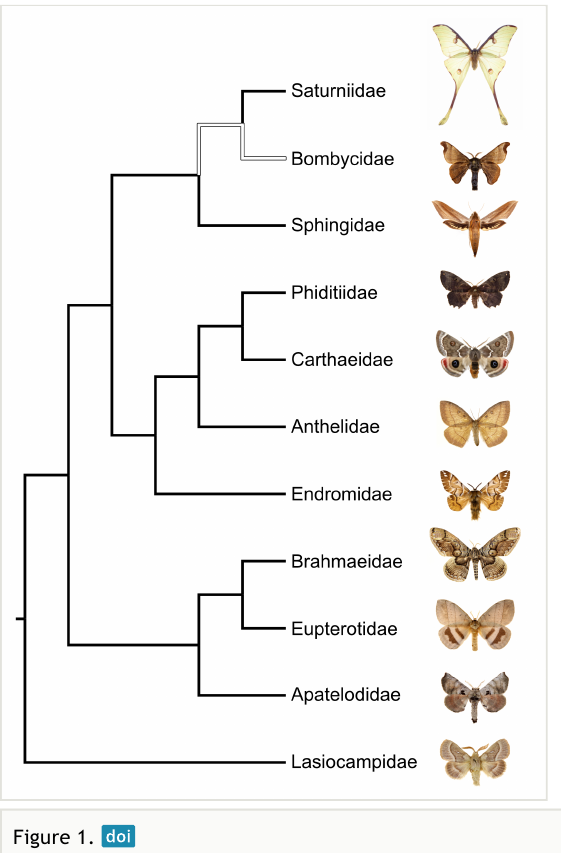
Simpli fi ed family-level phylogeny from Zwick et al. (2011). White branch indicates the uncertain placement (i.e., relationship to other families) of the Bombycidae. The closely related family Lasiocampidae is used as an outgroup to root the tree. Photographs at tips are representatives of each family: Saturniidae - Argema mimosae (Boisduval, 1847); Bombycidae - Bombyx mandarina Moore, 1882; Sphingidae - Xylophanes tersa (Linnaeus, 1771); Phiditiidae - Phiditia Möschler, 1882 species; Carthaeidae - Carthaea saturnioides Walker, 1858; Anthelidae - Anthela Walker, 1855 species; Endromidae - Endromis versicolora (Linnaeus, 1758); Brahmaeidae - Brahmaea paukstadtorum Naumann & Brosch, 2005; Eupterotidae - Jana eurymas Herrich-Schä ff er, 1854; Apatelodidae - Apatelodes torrefacta (Smith, J.E., 1797); Lasiocampidae - Lasiocampa terreni (Herrich-Schä ff er,